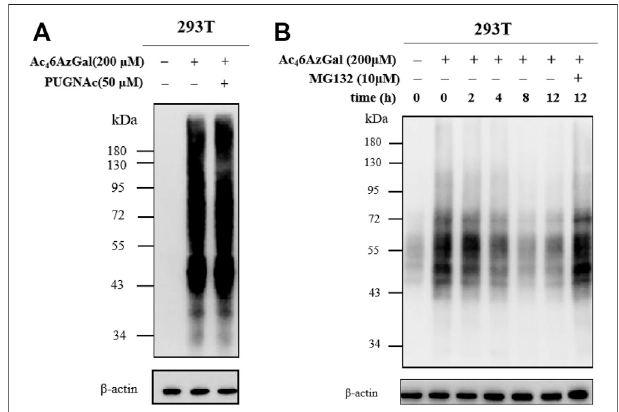
FIGURE 6 | Ac 4 6AzGal labeling is not mediated by OGA. inhibitor has no effect in the protein labeling of Ac 4 6AzGal; (B) Pulse-chase experiment indicates Ac 4 6AzGal labeling is degraded with the dependence of